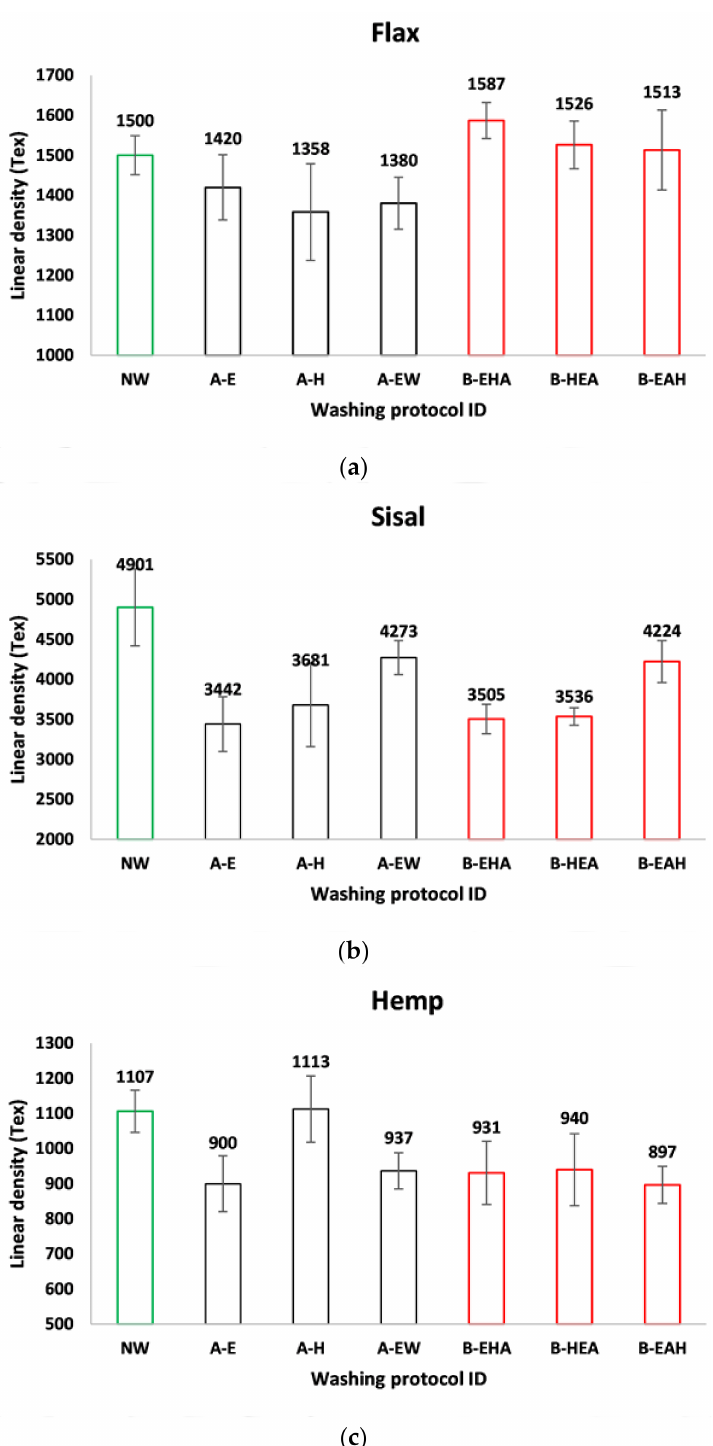
Figure 1. Linear density values of ( a ) flax, ( b ) sisal and ( c ) hemp before and after washing protocols with the corresponding standard